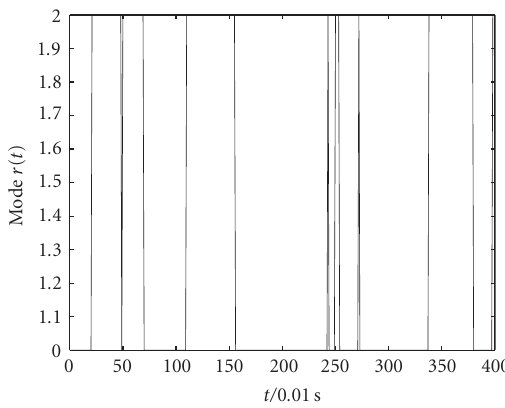
Figure 4.1. Regime transition in set-point tracking.